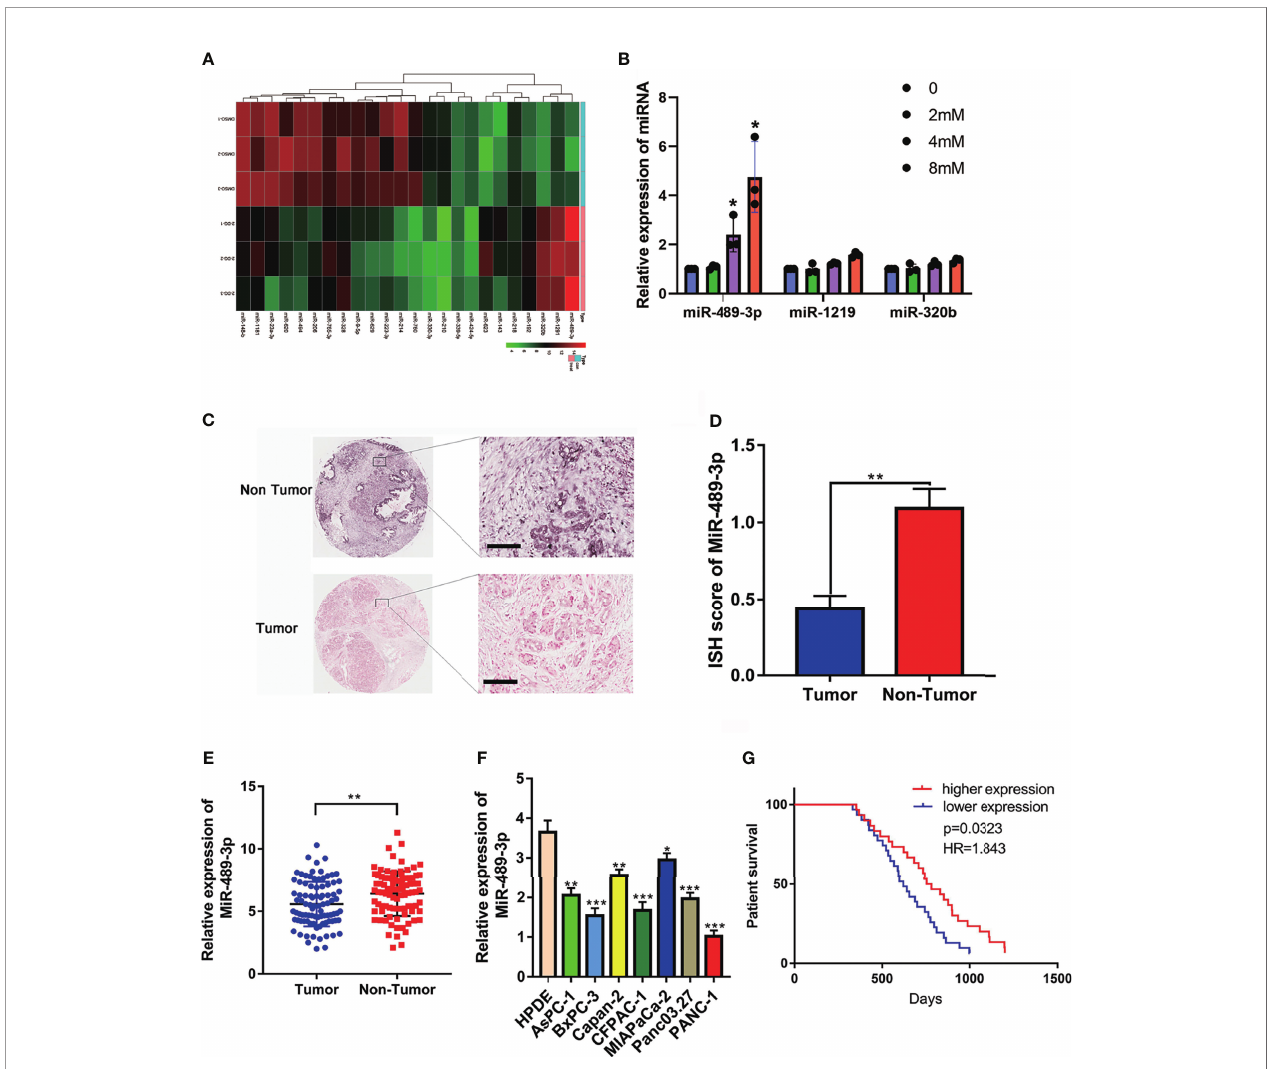
FIGURE 1 | The expression of miR-489-3p and its relationship with clinical prognosis of patients. (A) RNA-seq analysis the different expressed miRNAs associated with glycolysis. (B) q-RT-PCR analysis the upregulated miRNA in the exposure with glycolysis inhibitor 2-DG. (C, D) RNA in situ hybridization experiments showed the expression of miR-489-3p in paracancerous and cancerous tissues. The bar stands for 50 microns (E) qRT-PCR analysis of the relative expression of miR-489- 3p in adjacent tissues and PC tissues. (F) qRT-PCR showed the relative expression of miR-489-3p in PC cell lines and pancreatic normal duct epithelial cells (HPDE). (G) Kaplan-Meier curve was divided into survival periods by miR-489-3p expression. Among them, patients were divided into high expression group (red) and low expression group (blue) by median expression of miR-489-3p. (*P < 0.05, **P < 0.01, ***P <